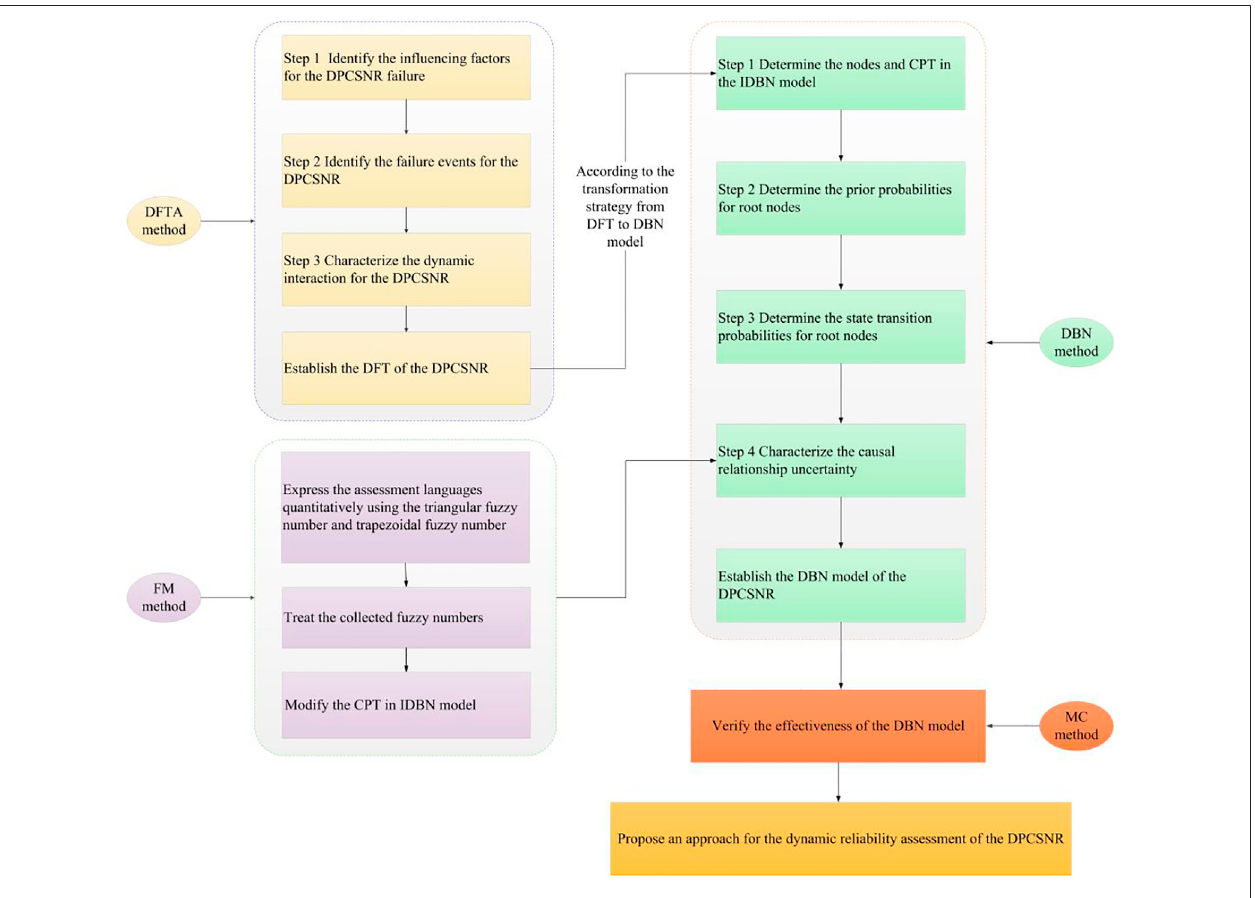
FIGURE 2 | Theoretical framework for the